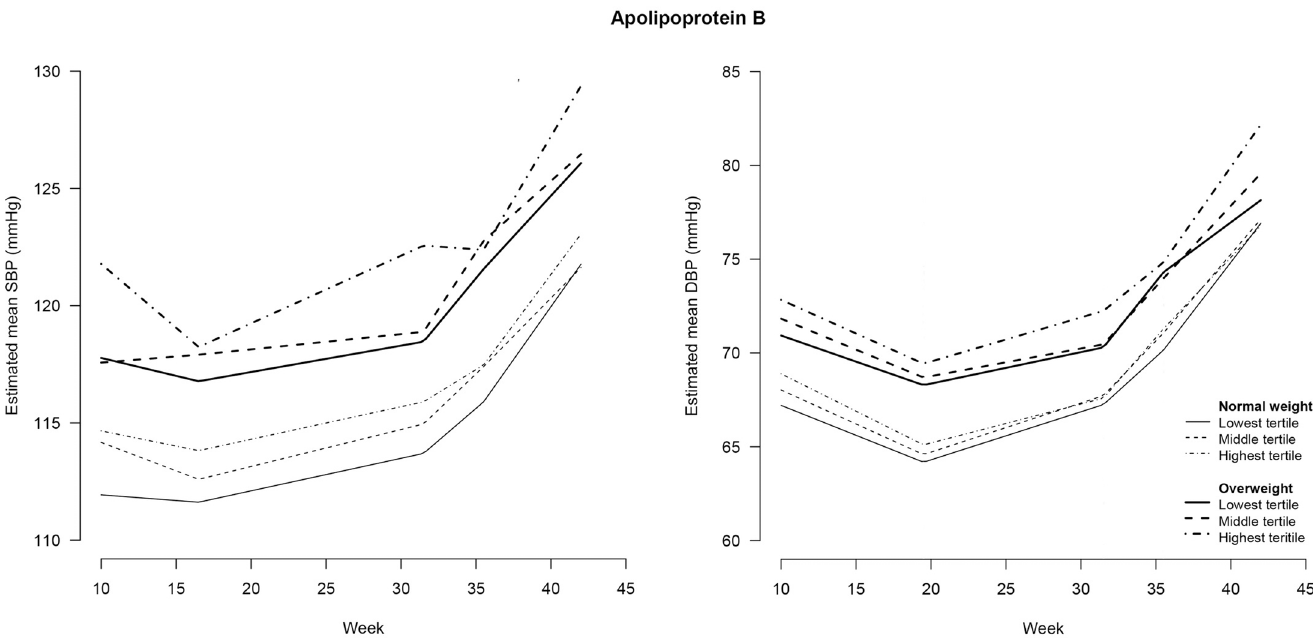
Fig 6. Blood pressure during pregnancy stratified for maternal weight status and tertiles of Apolipoprotein B # . SBP = systolic blood pressure; DBP = diastolicblood pressure. # Apolipoprotein B was determinedin non-fasting blood samples drawn at a medianof 13 (IQR = 12–14)weeks of gestation.